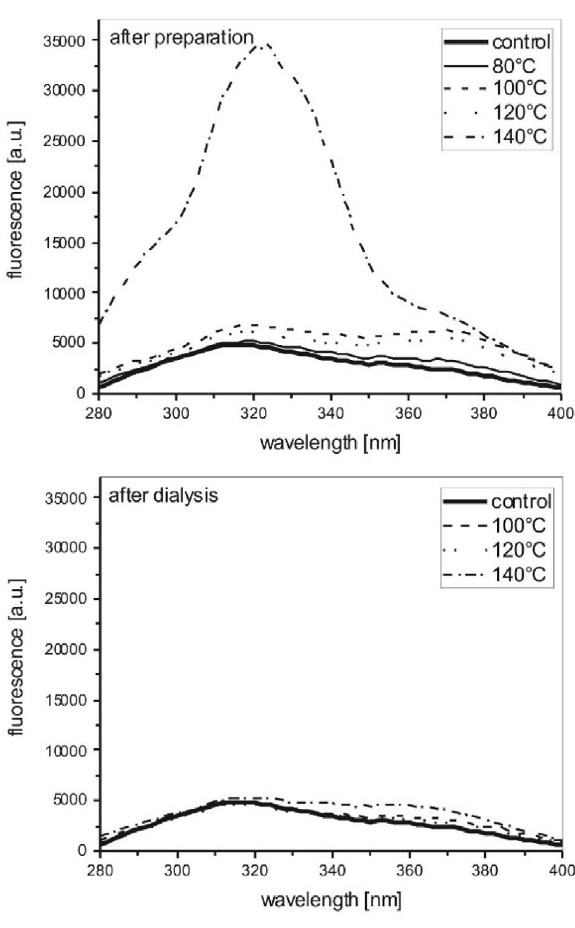
Figure 8. Fluorescence activation spectra of the prepared solutions. The activation is recorded for fluorescence light emitted at 440 nm. Presented are spectra from solutions prepared at different process temperatures with a process duration of 5 min.